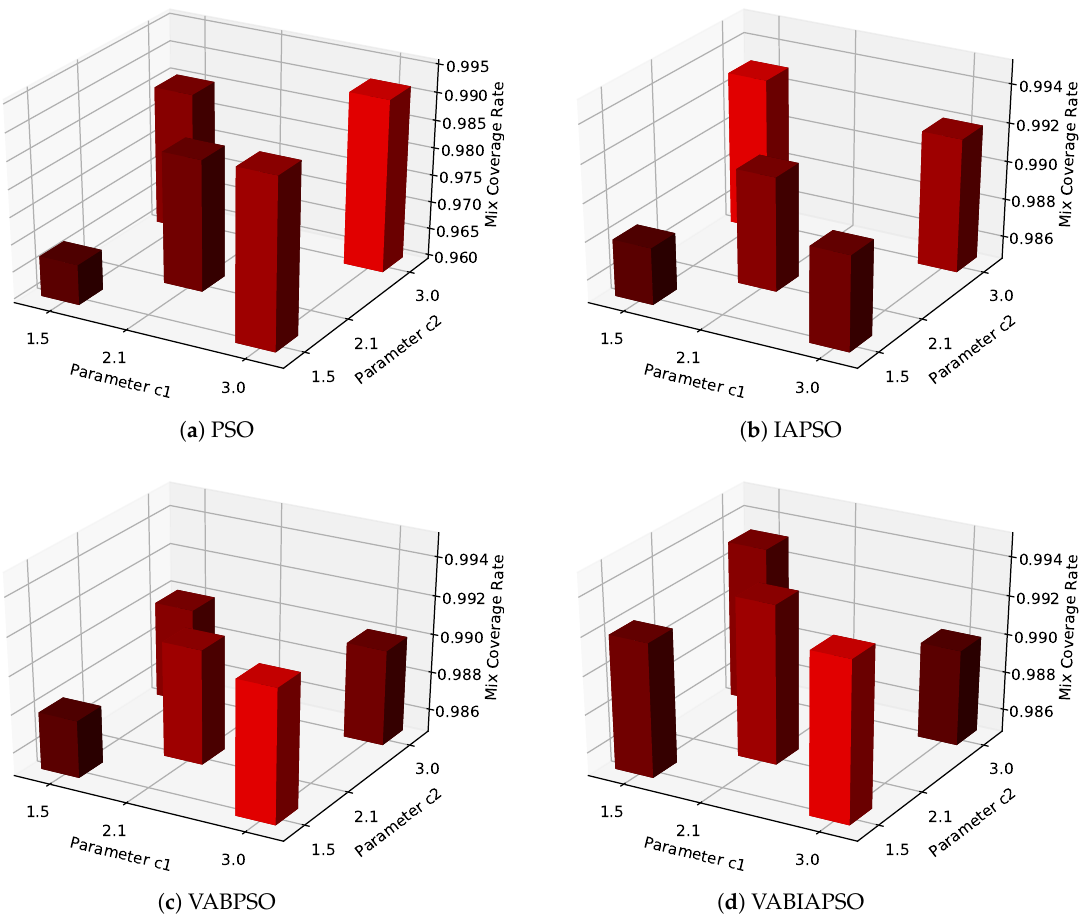
Figure 6. The mix coverage of the four algorithms under different values of C 1 and C 2 in the ideal scene. The value combinations of C 1 and C 2 are shown in the Figure 6 as values on the X -axis and Y -axis (1.5, 2.1, 3.0) respectively. The Z -axis histogram shows the maximum mix coverage rate that the algorithm can achieve under this combination of values. According to the mix coverage, C 1 = 3.0 and C 2 = 3.0 in Figure 6a are selected as the best parameters of the standard PSO algorithm, C 1 = 1.5 and C 2 = 3.0 in Figure 6b are selected as the best parameters of IASPO algorithm, C 1 = 3.0 and C 2 = 1.5 in Figure 6c,d are selected as the best parameters of VABPSO and VABIAPSO algorithms. Each diagram is highlighted in bright red. It is worth noting that in the VABIAPSO algorithm, the effect of multiple